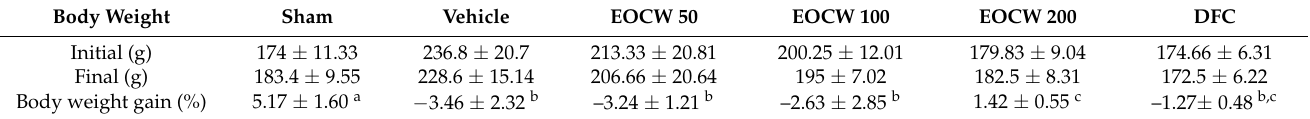
Table 4. Body weight variation of animals according to the experimental group.